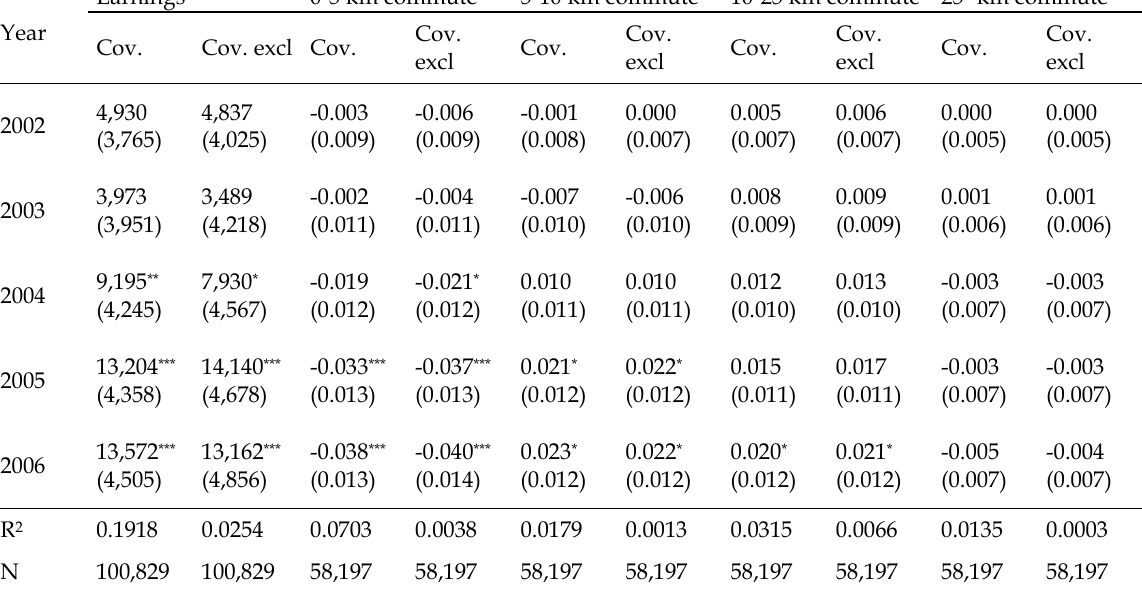
Table A2. Robustness of post-treatment effects of improved job accessibility to excluding covariate set